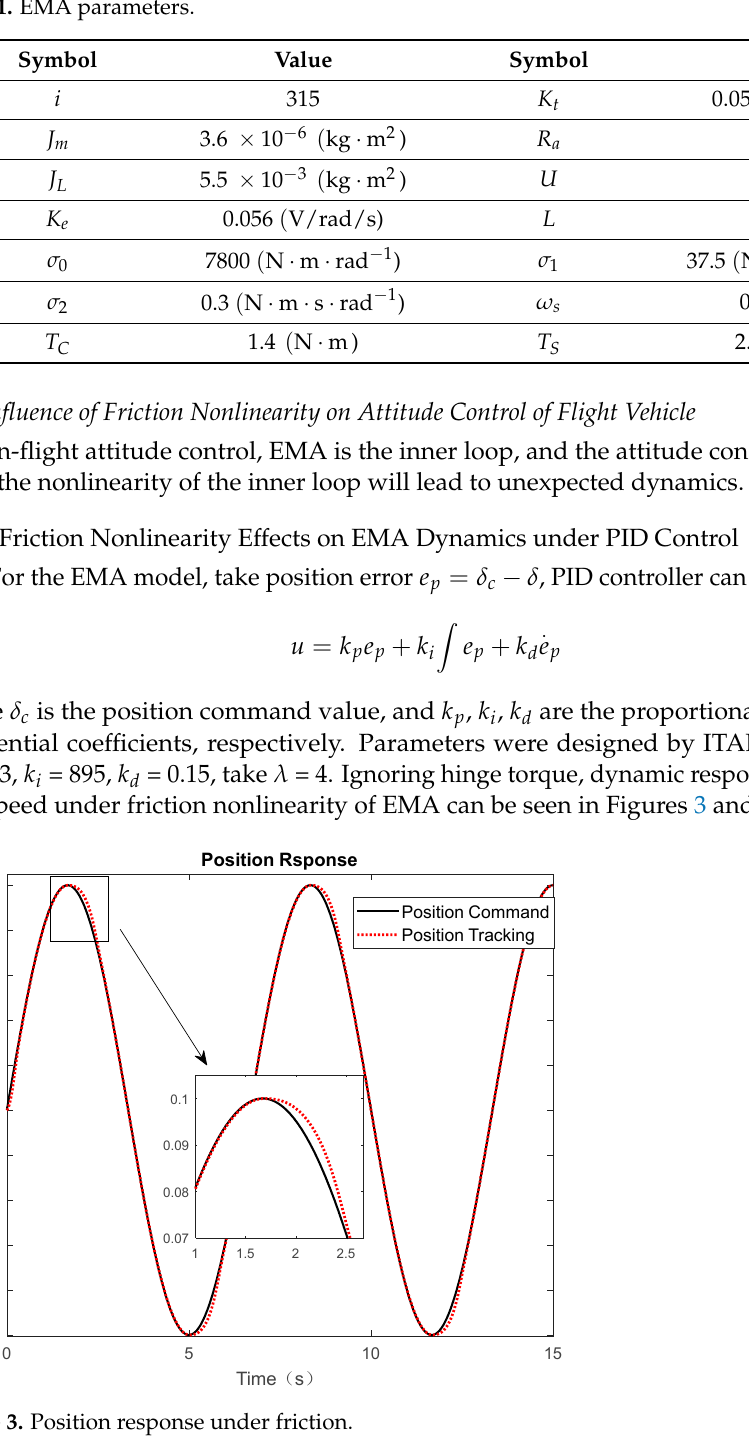
Figure 4. Speed response under friction. The simulation results show that, when the position command is small and the fre- quency is low, friction nonlinearity of EMA may cause the “flat top” phenomenon of po- sition tracking under PID control, meanwhile, speed curve distortion is generated. 2.2.2. Influence of EMA Friction Nonlinearity on Attitude of Flight Vehicle 1.